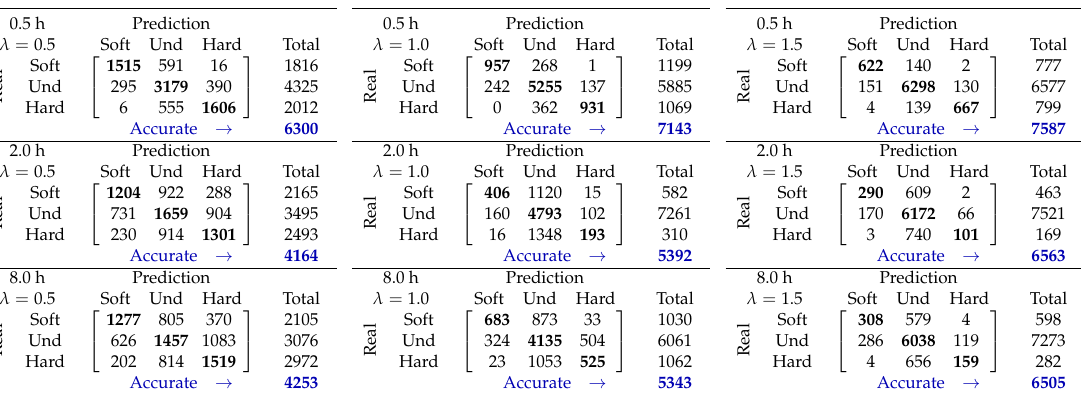
Table 4. SAG mill 1. Confusion matrices (number of instances) of operational relative-hardness (ORH) predictions using λ : 0.5, 1.0 and 1.5 at 0.5, 2 and 8 h time supports.